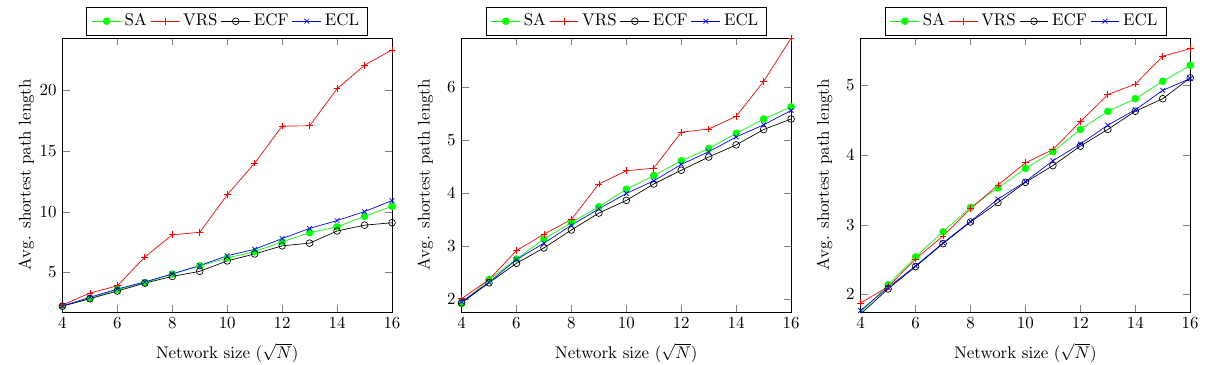
Figure 2. Comparison of average shortest path length (ASPL) for different networks and schemes: Ring as base topology ( left ), Mesh as base topology ( middle ), and Torus as base topology ( right ). As the networks scale up, proposed EdgeCut networks have lower latency compared to VRS and